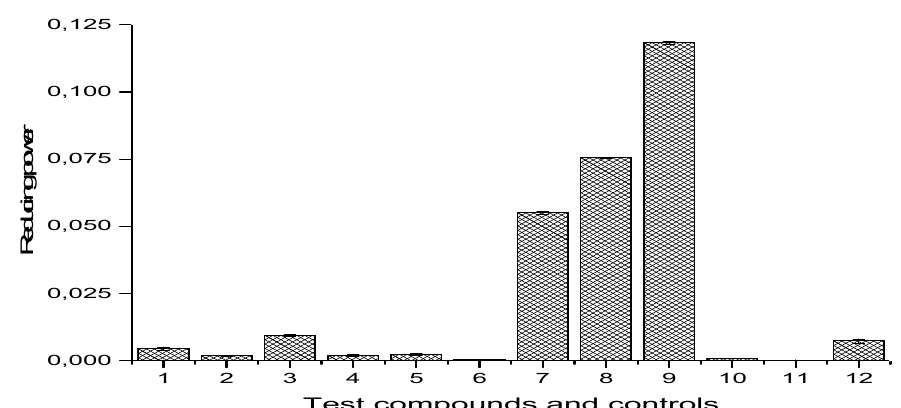
Figure 4. Reducing power of Schiff bases 1 – 9 and controls 10 – 12 measured at 700 nm (concentration of 200 µM). Each value is the mean ± SD.